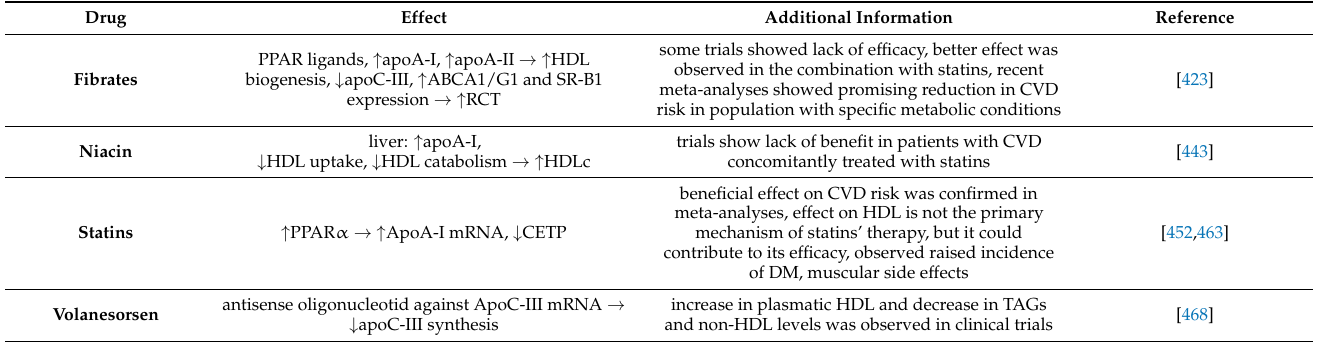
Table 3. HDL-affecting drugs used for cardiovascular application in clinical